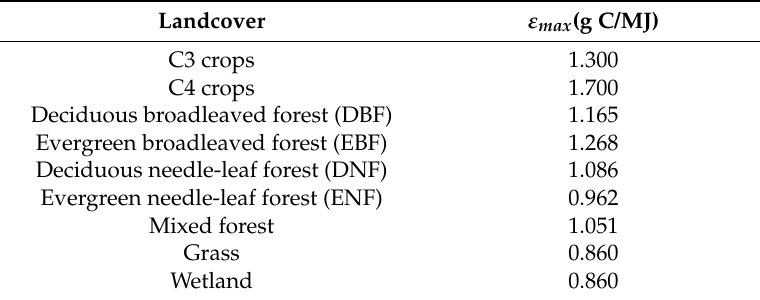
Table 1. Biome-specific potential LUE for different landcover